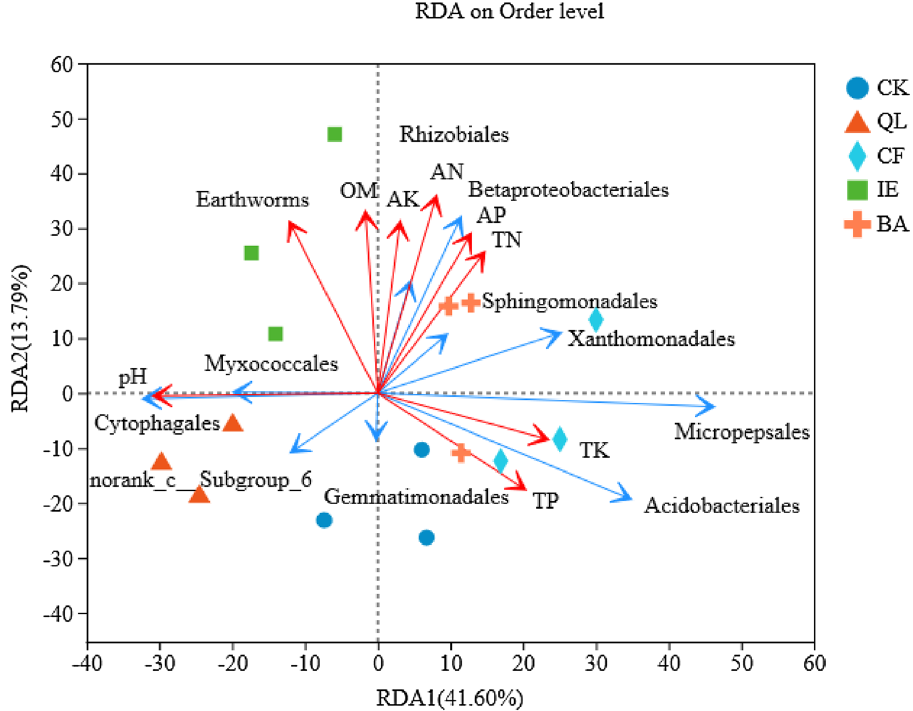
Figure 7. Redundancy analyses of the correlations between rhizosphere soil properties and bacterial community. The blue arrows represent different bacterial orders. The red arrows represent different environmental factors, the length of the arrow of environmental factors represent the degree of environmental factors’ influence on the species data (the amount of interpretation). CK blank control, QL quicklime, CF chemical fungicide, IE inoculation with earthworms, BA biocontrol agent.